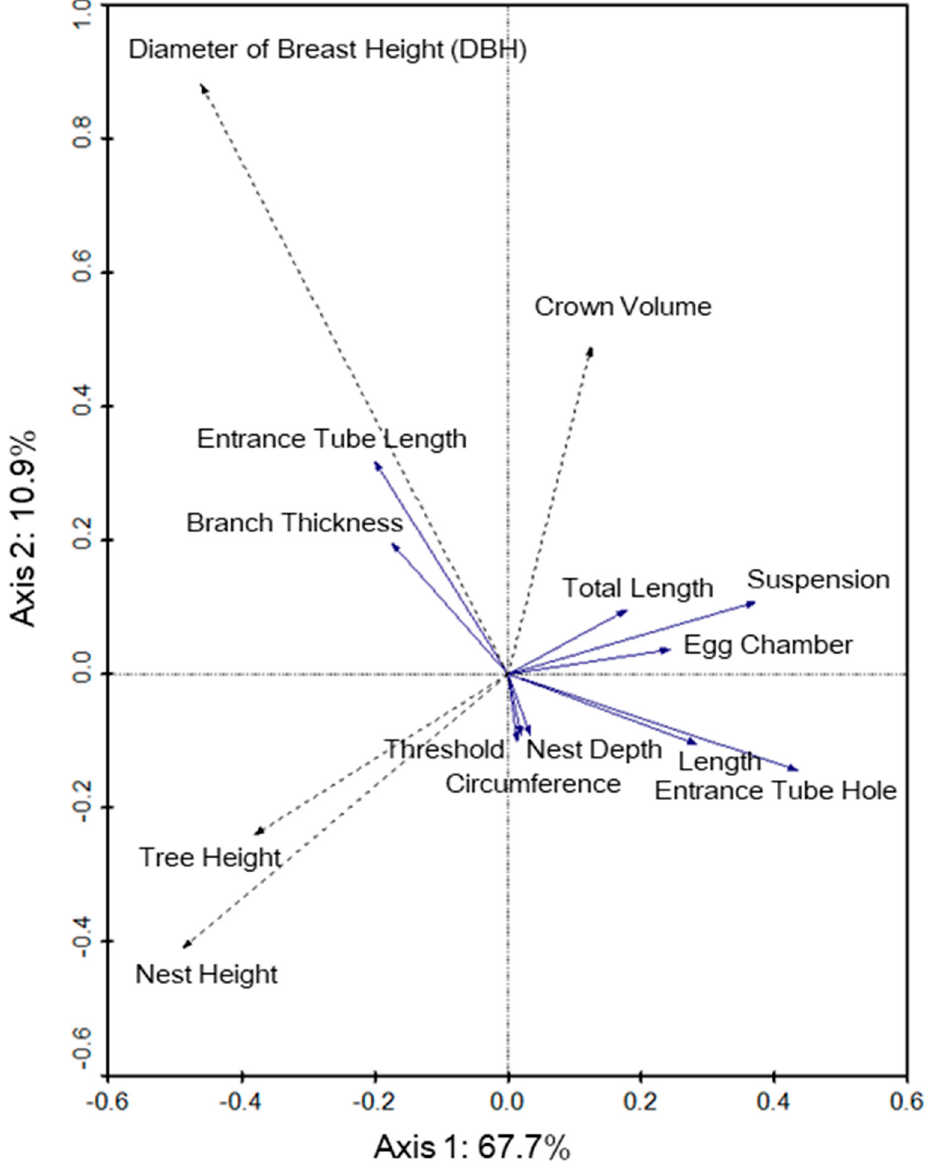
Figure 6. Redundancy analysis biplot of the baya weaver ( Ploceus philippinus ) nest structure (solid line vectors) and nest tree variables (dotted line vectors) for the Perlis site. Arrows indicate the direction that nest structure increased in measurement whereas the angles between variables approximate their correlations.